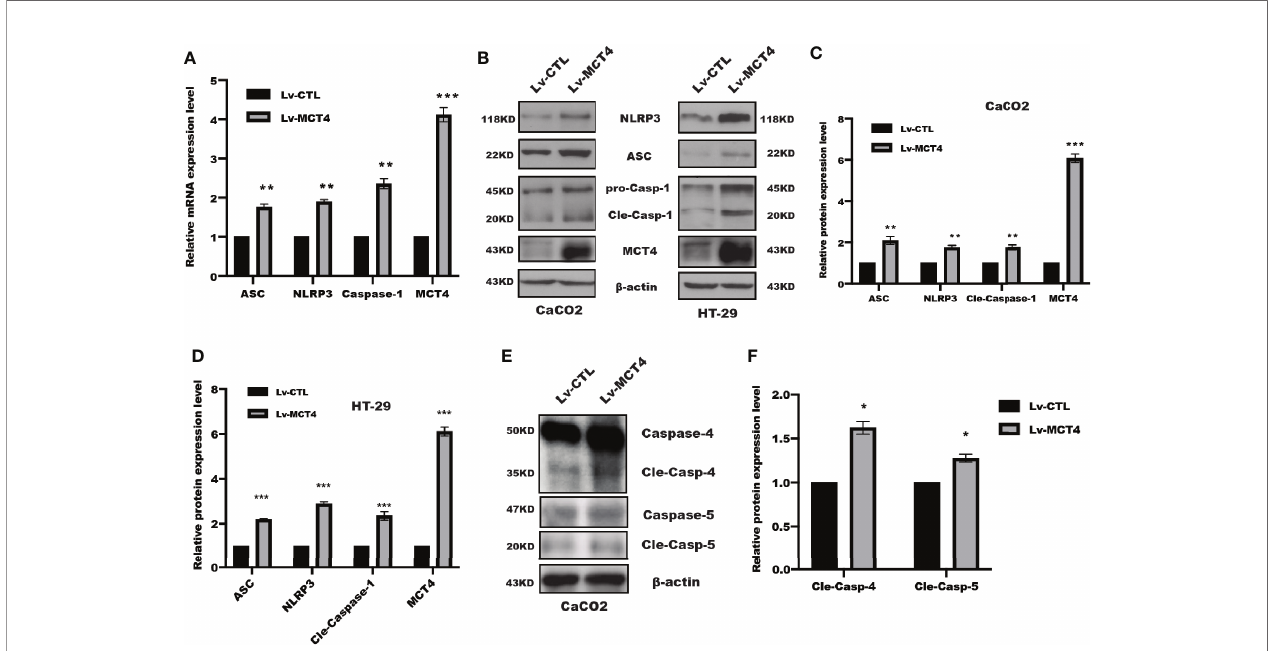
FIGURE 2 | MCT4 promoted NLRP3 in fl ammasome activation. (A) Real-time PCR was performed to analyze the indicated gene expression in CaCO2 cells with or without MCT4 overexpression; data represented the mean ± s.d. of three independent experiments; t tests were used to analyze statistical signi fi cance; *** p < 0.001, ** p < 0.01, n = 3. (B) Western blotting was used to detect NRLP3, ASC, Caspase-1, and MCT4 expression in the indicated group of HT-29 and CaCO2 cells. MCT4 was used to con fi rm the overexpression ef fi ciency; b -actin served as internal control. The expression of the indicated proteins was assessed and quanti fi ed in CaCO2 (C) and HT-29 cells (D) . Data represented the mean ± s.d. of three independent experiments; t tests were used to analyze statistical signi fi cance; *** p < 0.001, ** p < 0.01, n = 3. (E) Immunoblotting of Caspase-4 and Caspase-5 was performed in CaCO2 cells with or without MCT4 overexpression. (F) The expression of indicated proteins was assessed and quanti fi ed; data represented the mean ± s.d. of three independent experiments; t tests were used to analyze statistical signi fi cance, * p <